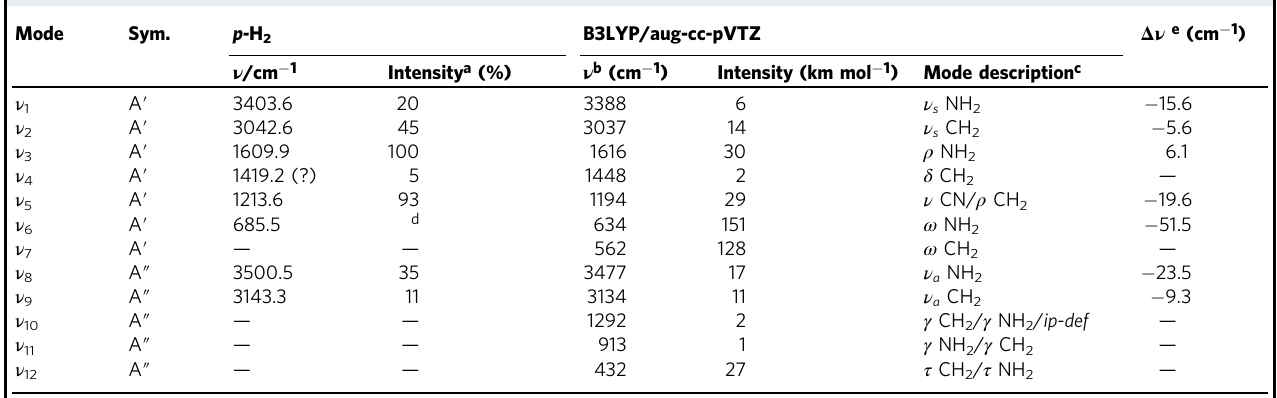
Table 1 Comparison of observed wavenumbers and relative IR intensities of • CH 2 NH 2 in solid p -H 2 with their scaled harmonic vibrational wavenumbers and IR intensities predicted with the B3LYP/aug-cc-pVTZ method. Mode Sym.